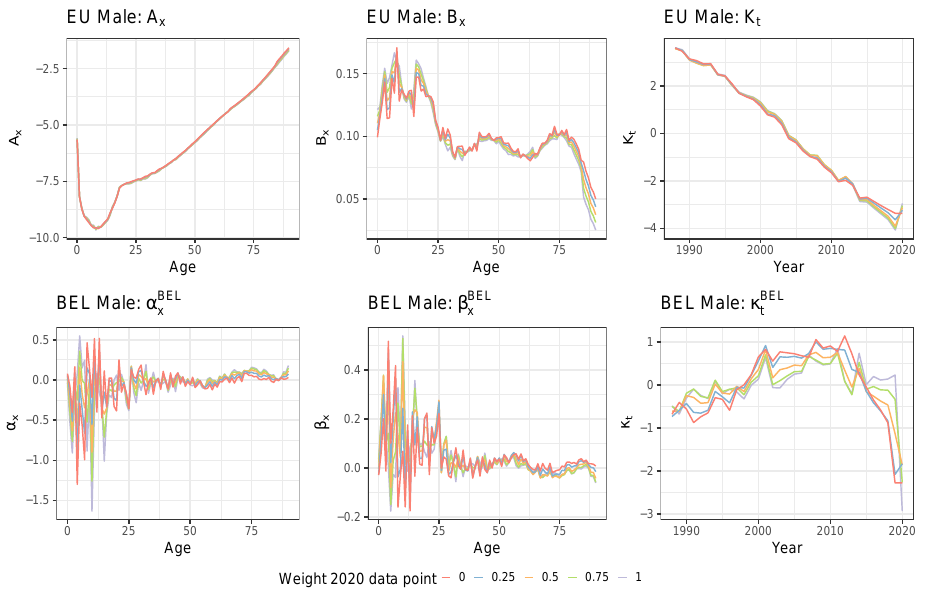
Figure 11. The European and Belgian parameters ˆ A x , ˆ B x , ˆ α x , ˆ β x , ˆ K t and ˆ κ t in the adjusted Lee and Miller mortality model for males. The coloured lines correspond to the different weighting scenarios in the calibration set-up. The mortality model is calibrated on data from 1988 to 2020 and contains virtually created deaths and exposures for the years 2019–2020.